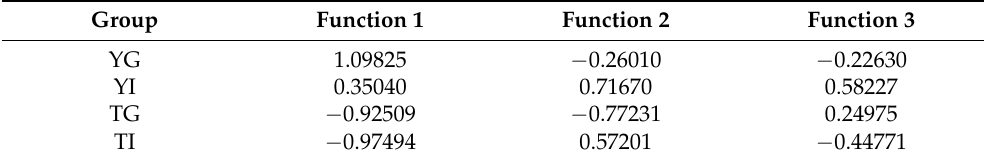
Table 4. Group centroids and canonical discriminant